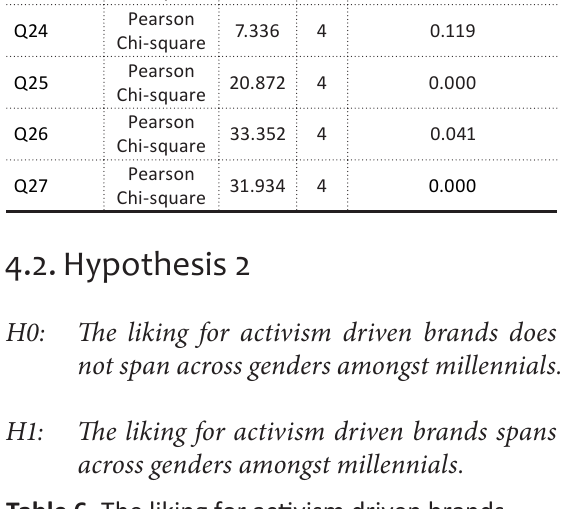
Table 6. The liking for activism driven brands spans across genders amongst